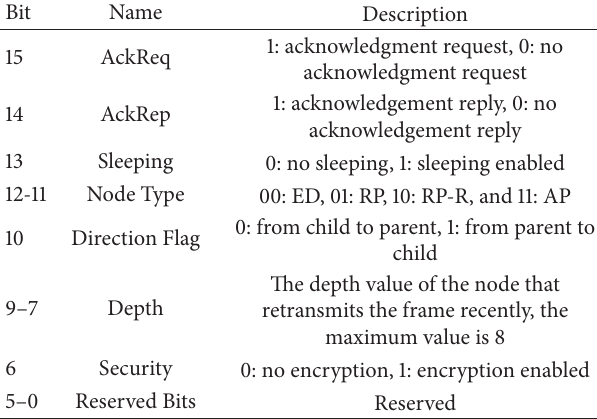
Table 3: CtrlInfo bit